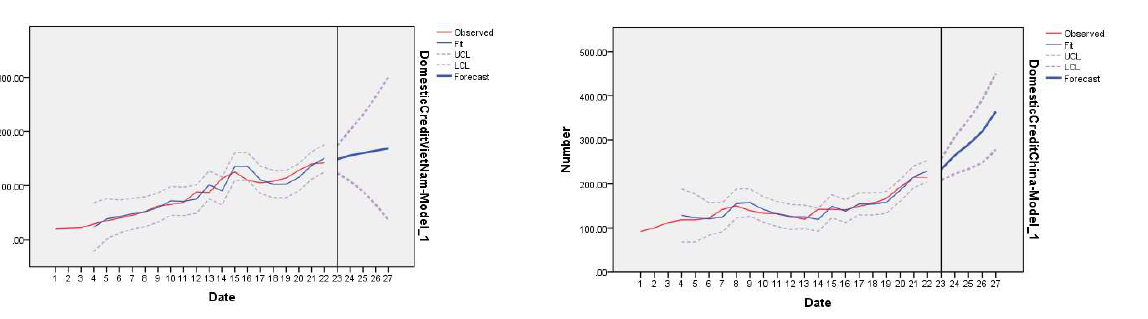
Fig. 9. Vietnam’s forecast of Domestic Credit-Model Fig. 10. China’s forecast of Domestic